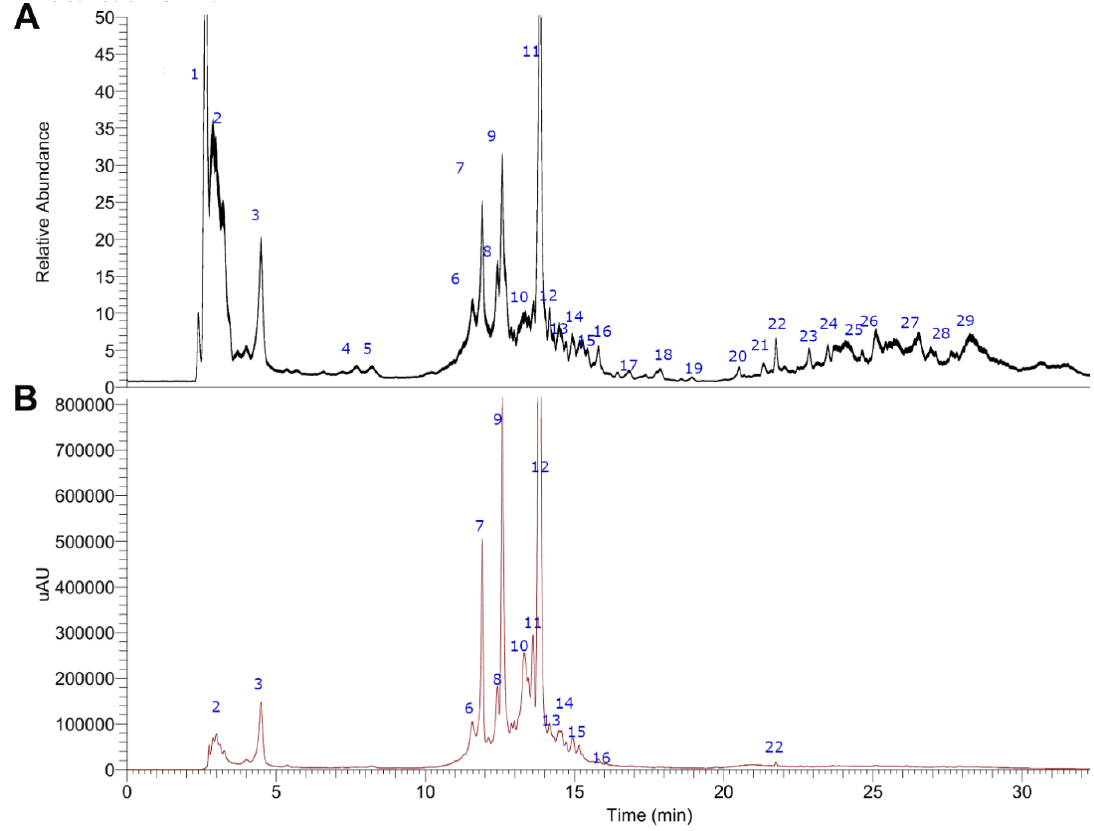
Figure 1. Ultra-high-performance liquid chromatography (UHPLC) chromatogram of MIE analyzed in positive ion mode. Total ion current ( A ), UV at 280 nm ( B ).